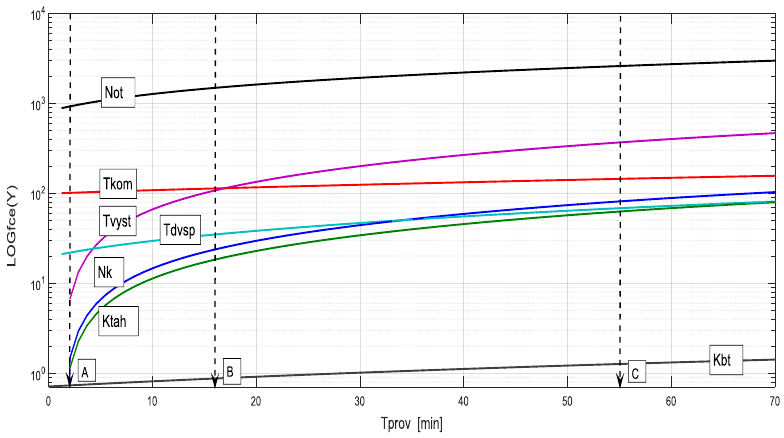
Figure 6. Relations between the main regulation parameters of boiler with power output up to 100 kW.